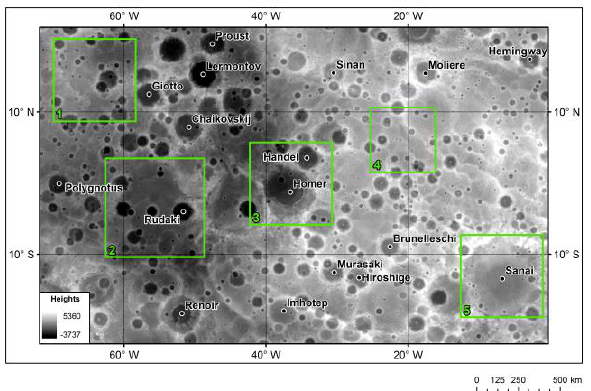
Figure 4. Mercury high-resolution DEM (~222 m/pixel) on Kuiper quadrant